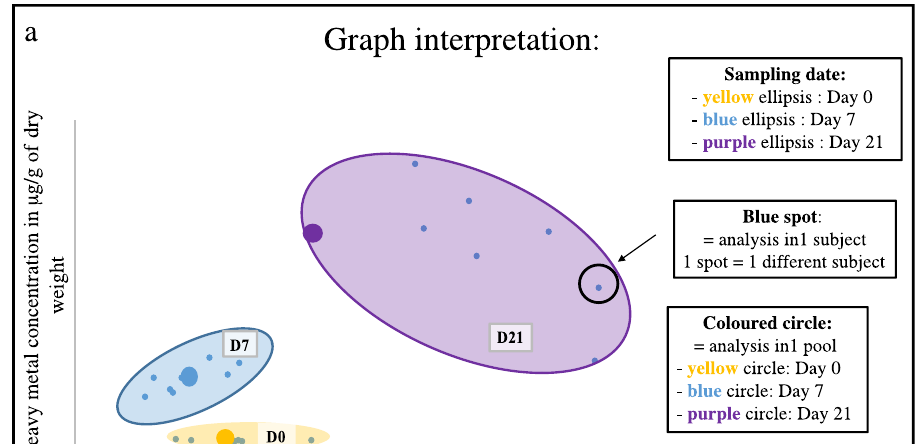
PLOS ONE | https://doi.org/10.1371/journal.pone.0198255 June 25,